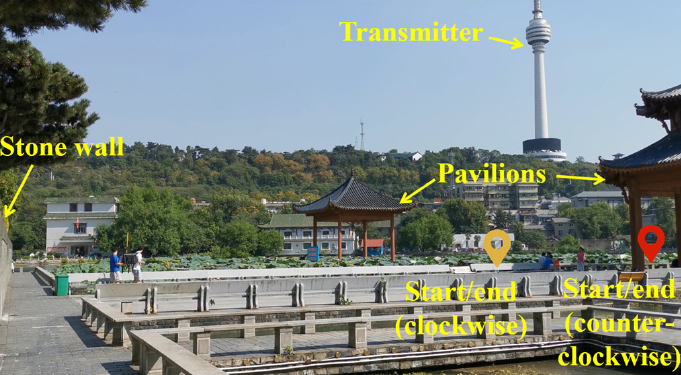
Figure 4. Surroundings along the walking route in the dynamic test in Wuhan.